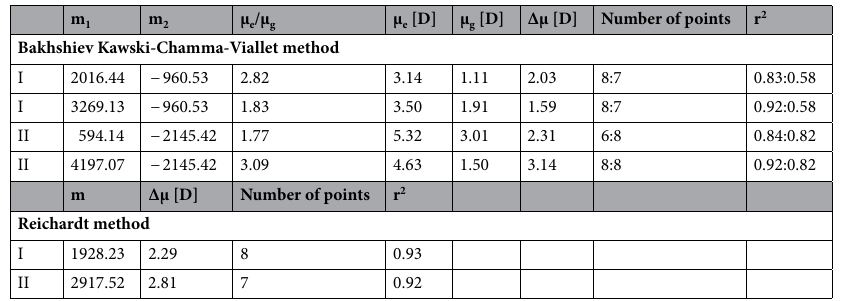
Table 1. Slopes m 1 and m 2 determined using respectively the plot of Stokes shifts against function F 1 (ε,n) and the plot of ( v a + v f )/2 against F 2 ( ε , n ) . Slope m was determined using the plot of Stokes shifts against function µ g , excited-state dipole moment µ e , change in dipole moment ∆μ, E N T along with ground-state dipole moment number of points and correlations factor r 2 determined for both positions of maximum absorbance (I ~ 320 nm and II ~ 286 nm) for